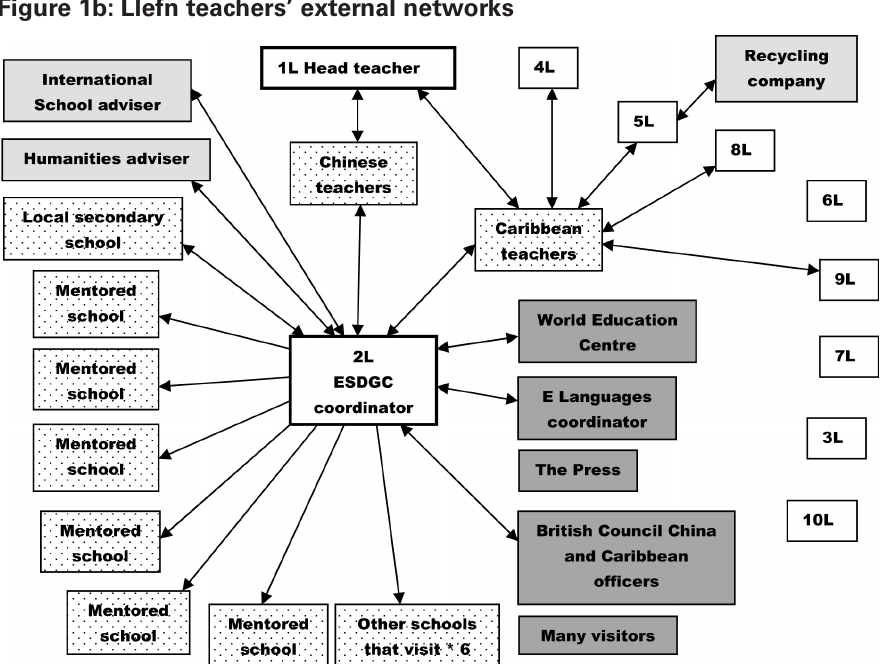
Figure 1b: Llefn teachers’ external